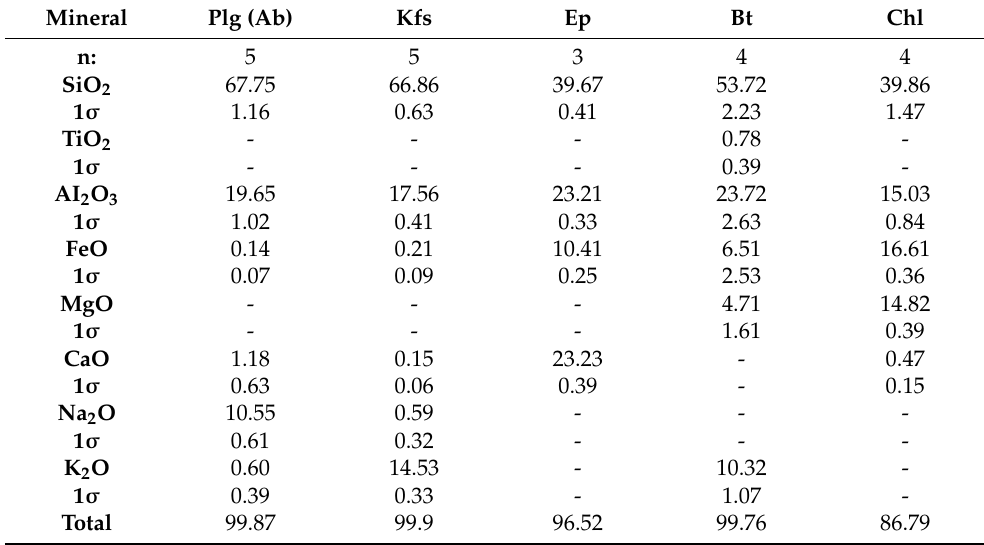
Table 3. Average and 1 σ standard deviation mineral chemistry values of selected sandstone samples from the Southern Eptachori Formation. Abbreviations: Plg: plagioclase, Ab: albite, Kfs: K-feldspar,